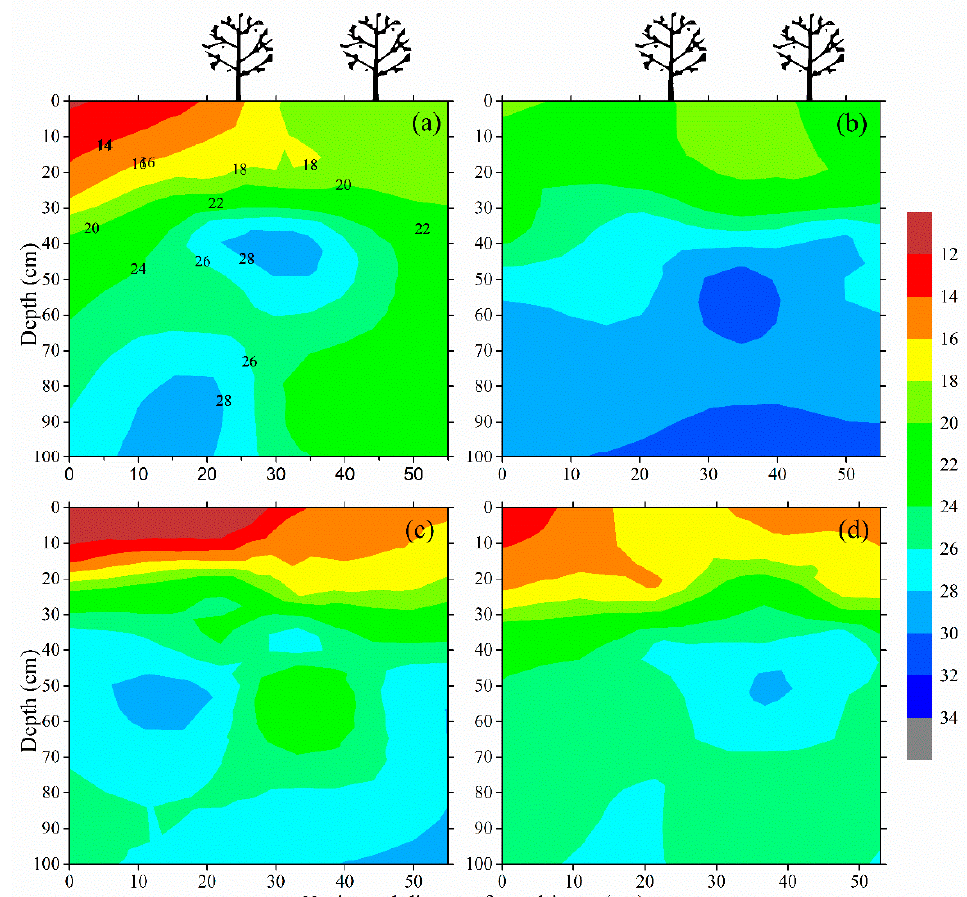
Figure 5. Distribution of soil salinity and soil texture at different soil depths in salt wastelands under